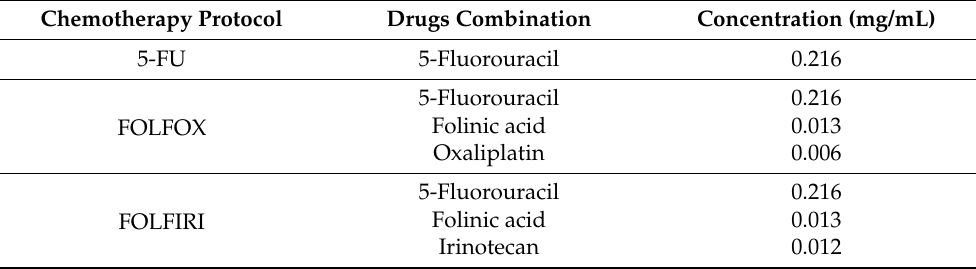
Table 1. Colorectal cancer zPDXs were treated with 5-FU, FOLFOX, FOLFIRI, FOLFOXIRI chemother- apy protocols. The drugs in the combinations and their concentrations are reported. Chemotherapy